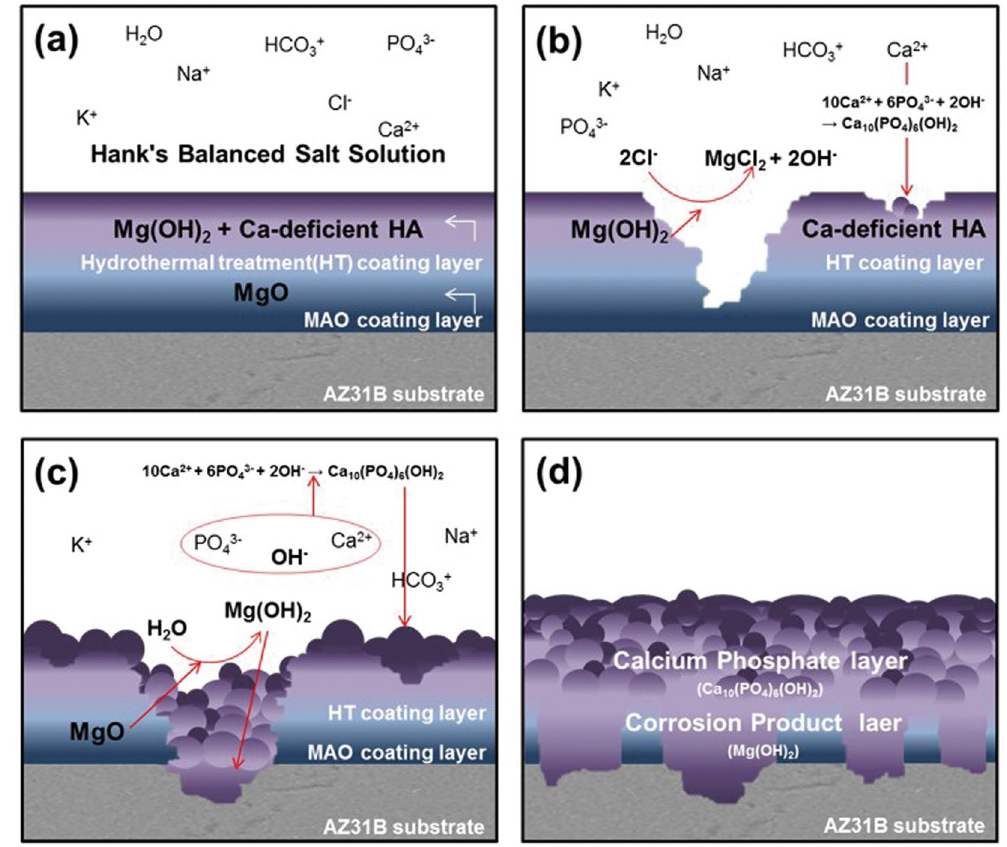
Figure 6. Schematic illustration ( a–d ) of the reactions on the surface of the magnesium alloy in